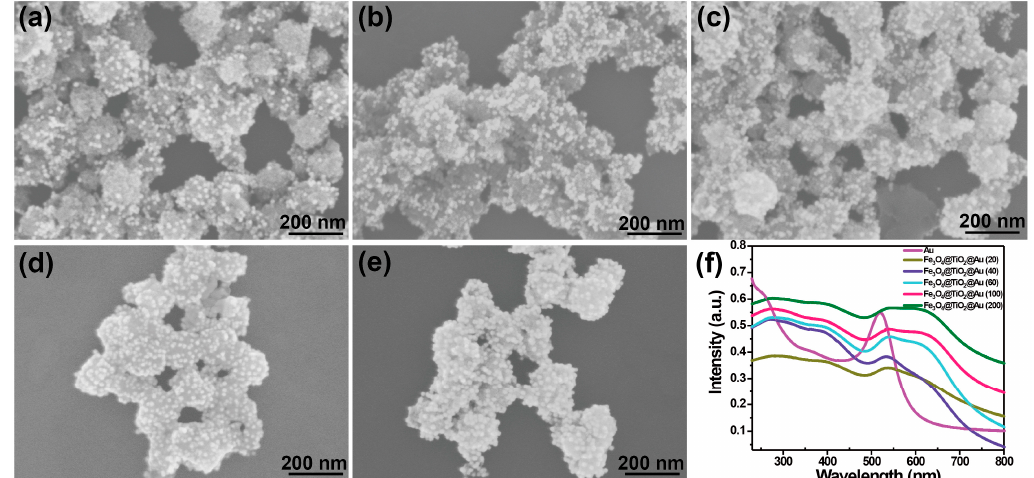
Figure 3. SEM images of the obtained Fe 3 O 4 @TiO 2 @Au nanocomposites synthesized under different volumes of Au seeds. ( a ) 20; ( b ) 40; ( c ) 60; ( d ) 100; and ( e ) 200 mL; and ( f ) their corresponding UV-Vis absorption spectra. Table 1. Zeta potential measurements.